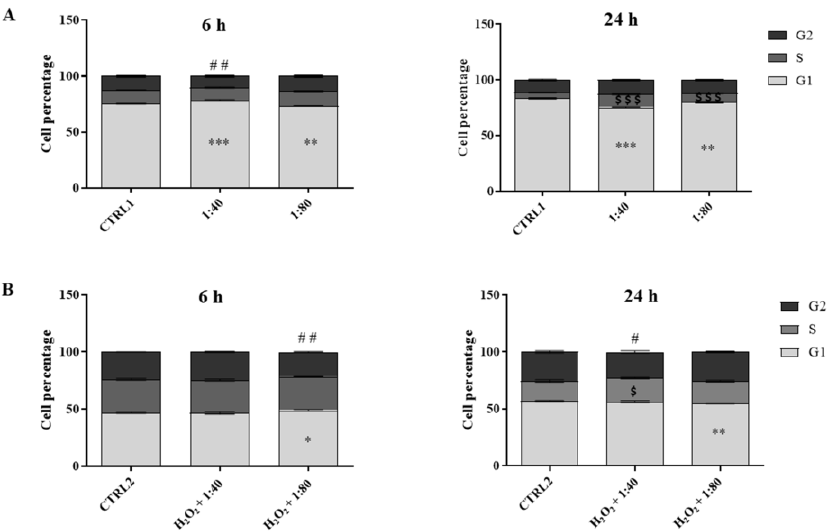
Figure 5. Cell cycle analysis in HGFs exposed for 6 and 24 h to DMEM culture medium (CTRL1),